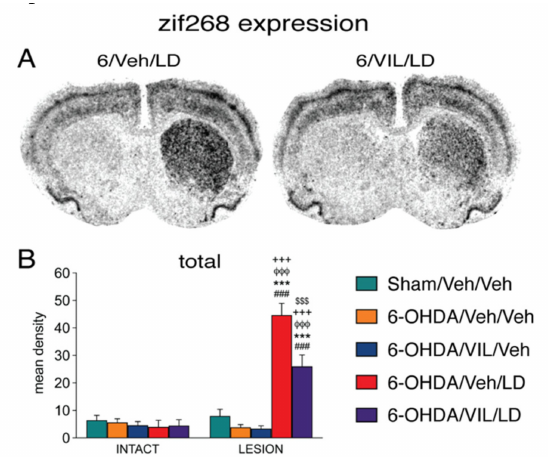
Figure 6. Vilazodone inhibited the L-DOPA-induced zif268 expression in the dopamine-depleted striatum. ( A ) Illustrations of film autoradiograms depict the expression of zif268 in sections from the mid-level striatum in rats with a 6-OHDA lesion (right hemisphere) followed by repeated vehicle + L-DOPA (6-OHDA / Veh / LD) or vilazodone + L-DOPA treatment (6-OHDA / VIL / LD). Rats were killed 60 min after the L-DOPA injection. ( B ) Mean density values (mean ± SEM) for zif268 expression in the striatum on the intact side or the side of the lesion in the sham lesion controls (Sham / Veh / Veh) and the 6-OHDA / Veh / Veh, 6-OHDA / VIL / Veh, 6-OHDA / Veh / LD, and 6-OHDA / VIL / LD groups, measured in the total middle striatum. ### p < 0.001 vs. same group on the intact side; *** p < 0.001 vs. Sham / Veh / Veh; ϕϕϕ p < 0.001 vs. 6-OHDA / Veh / Veh; +++ p < 0.001 vs. 6-OHDA / VIL / Veh; $$$ p < 0.001 vs. 6-OHDA / Veh /